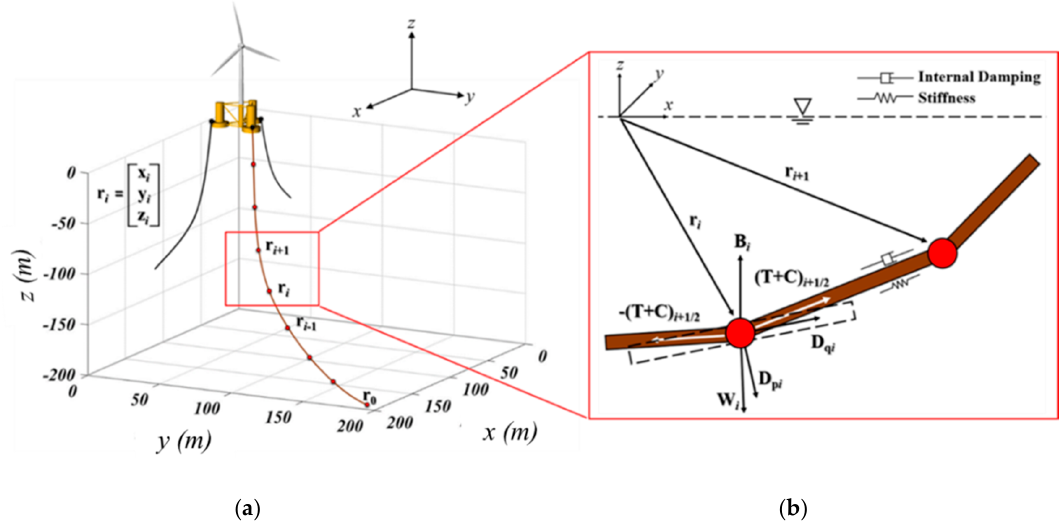
Figure 4. Description of dynamic mooring model: ( a ) the discretization of a mooring cable; ( b ) internal and external forces of a dynamic mooring cable.